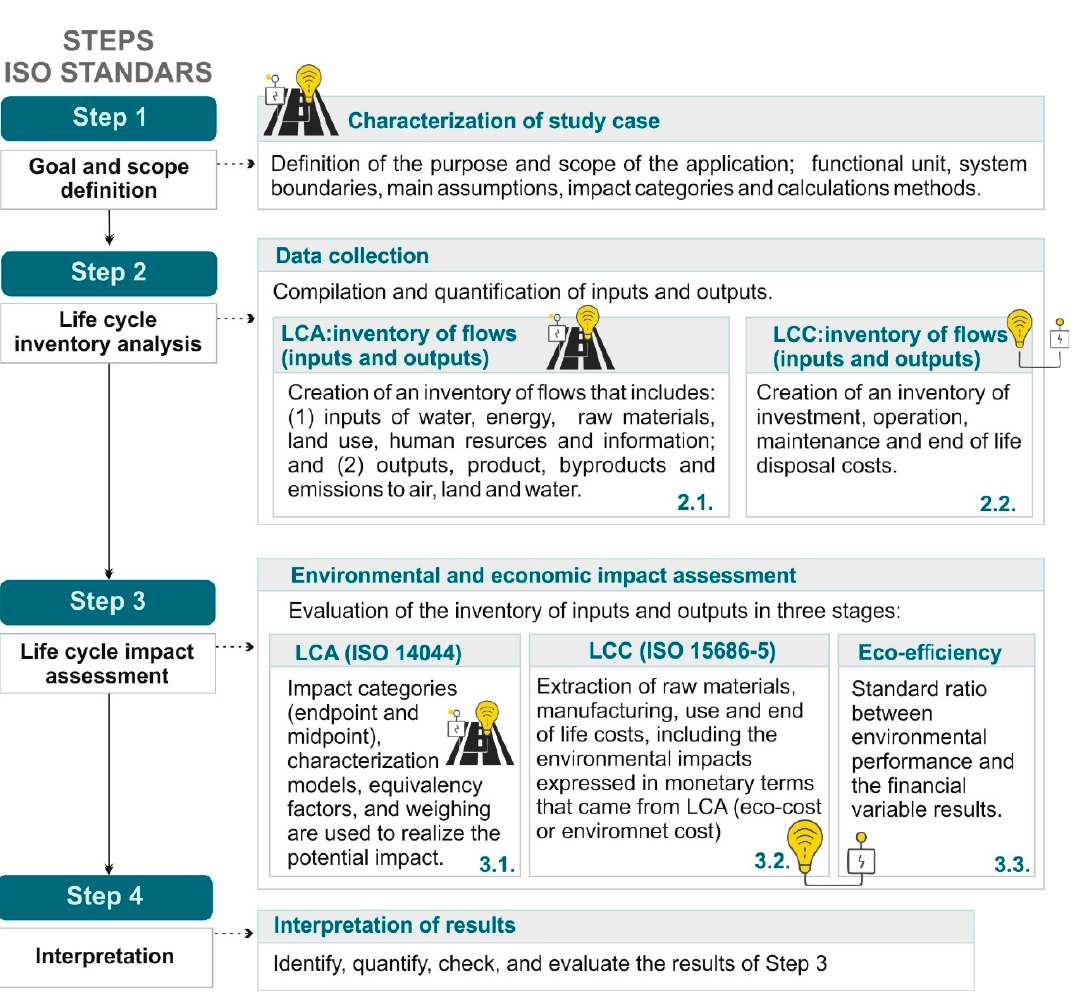
Figure 1. Life cycle assessment approach.